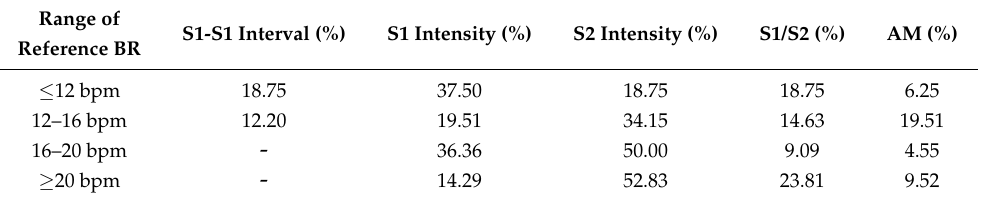
Table 9. Percentage of respiratory poles identified by the proposed method fusion technique from either one of the respiratory